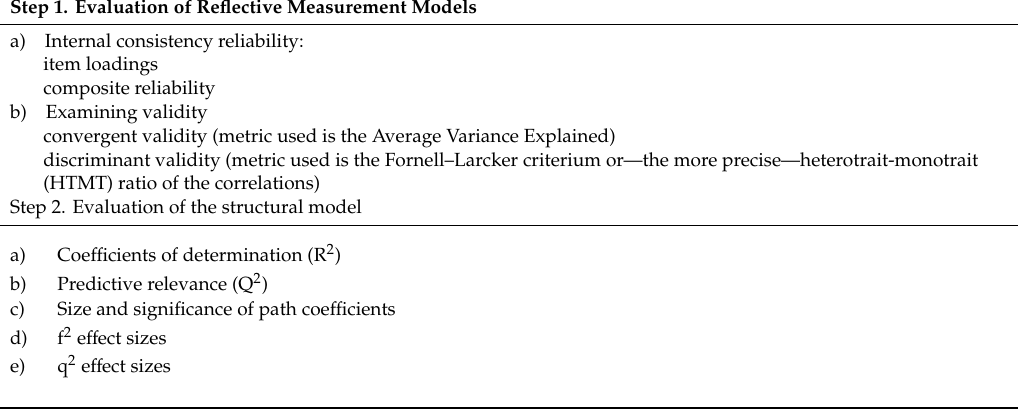
Table 1. Stepwise process to evaluate model